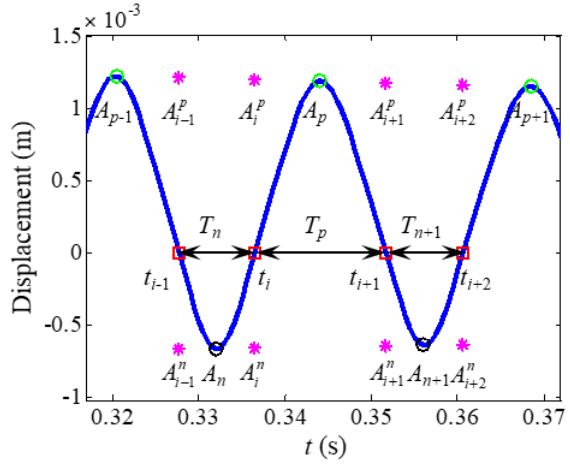
Figure 2. Zero-crossing with peak picking method for the asymmetric signal. Solid line, time-domain response; □ , zero-crossing points; ○ , positive peak points; ○ , negative peak points; *, envelopes at zero-crossing points obtained by interpolation.